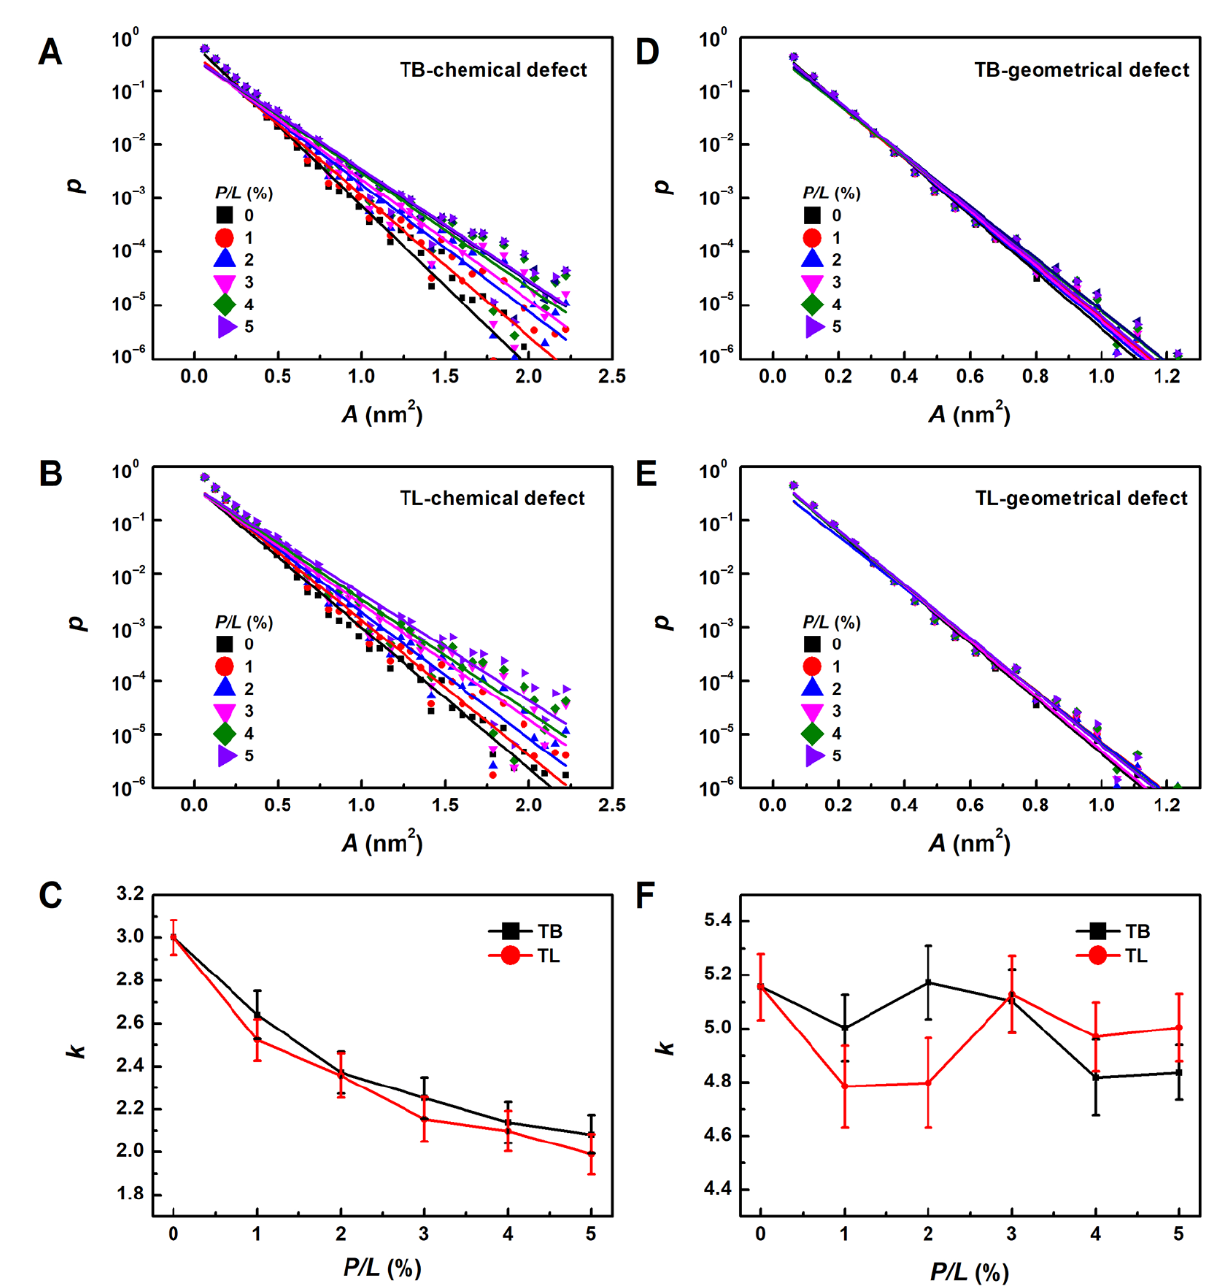
Figure 9. Emerging probability of chemical lipid packing defect as a function of defect area induced by TBs ( A ) and TLs ( B ). ( C ) Exponential decay rates of chemical defect at various peptide concentration. ( D – F ) correspond to geometrical lipid packing defects.